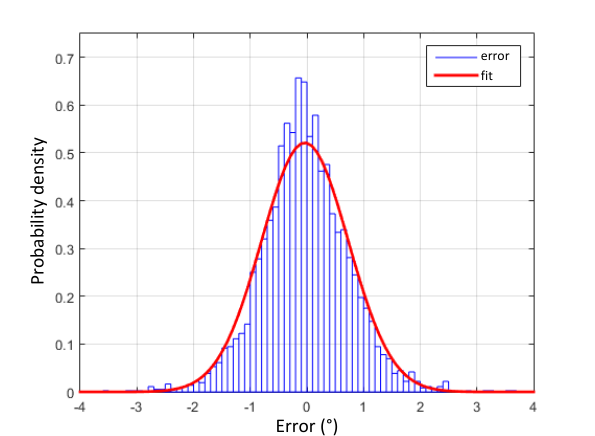
Figure 21. Probability density function of error in the roll angle estimation.